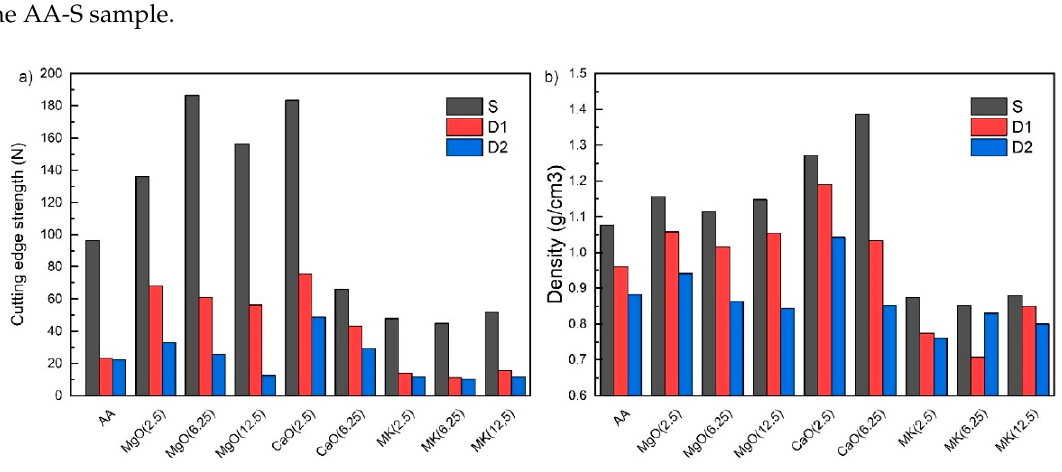
Figure 6. Cutting edge strength ( a ) and density ( b ) of all samples.